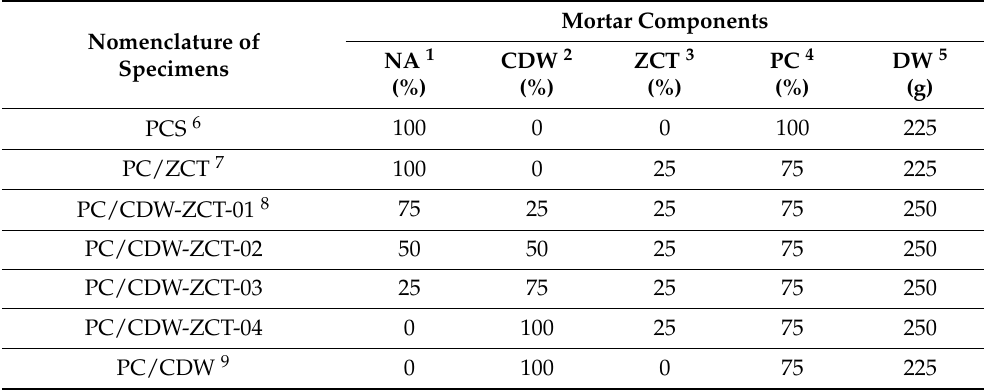
Table 2. Formulation of mortar mixtures made with different proportions of PC, NS, CDW, ZCT and DW, in accordance with the procedures of the Standard UNE-EN 196-1:2018 [32].